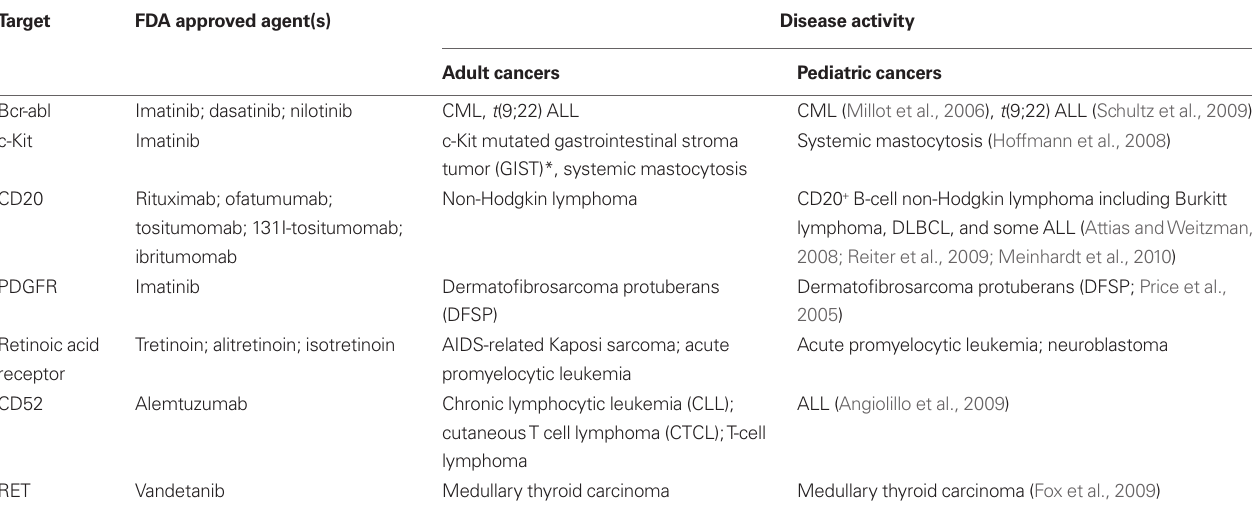
Table 1 | FDA approved targeted agents with demonstrated activity in pediatric